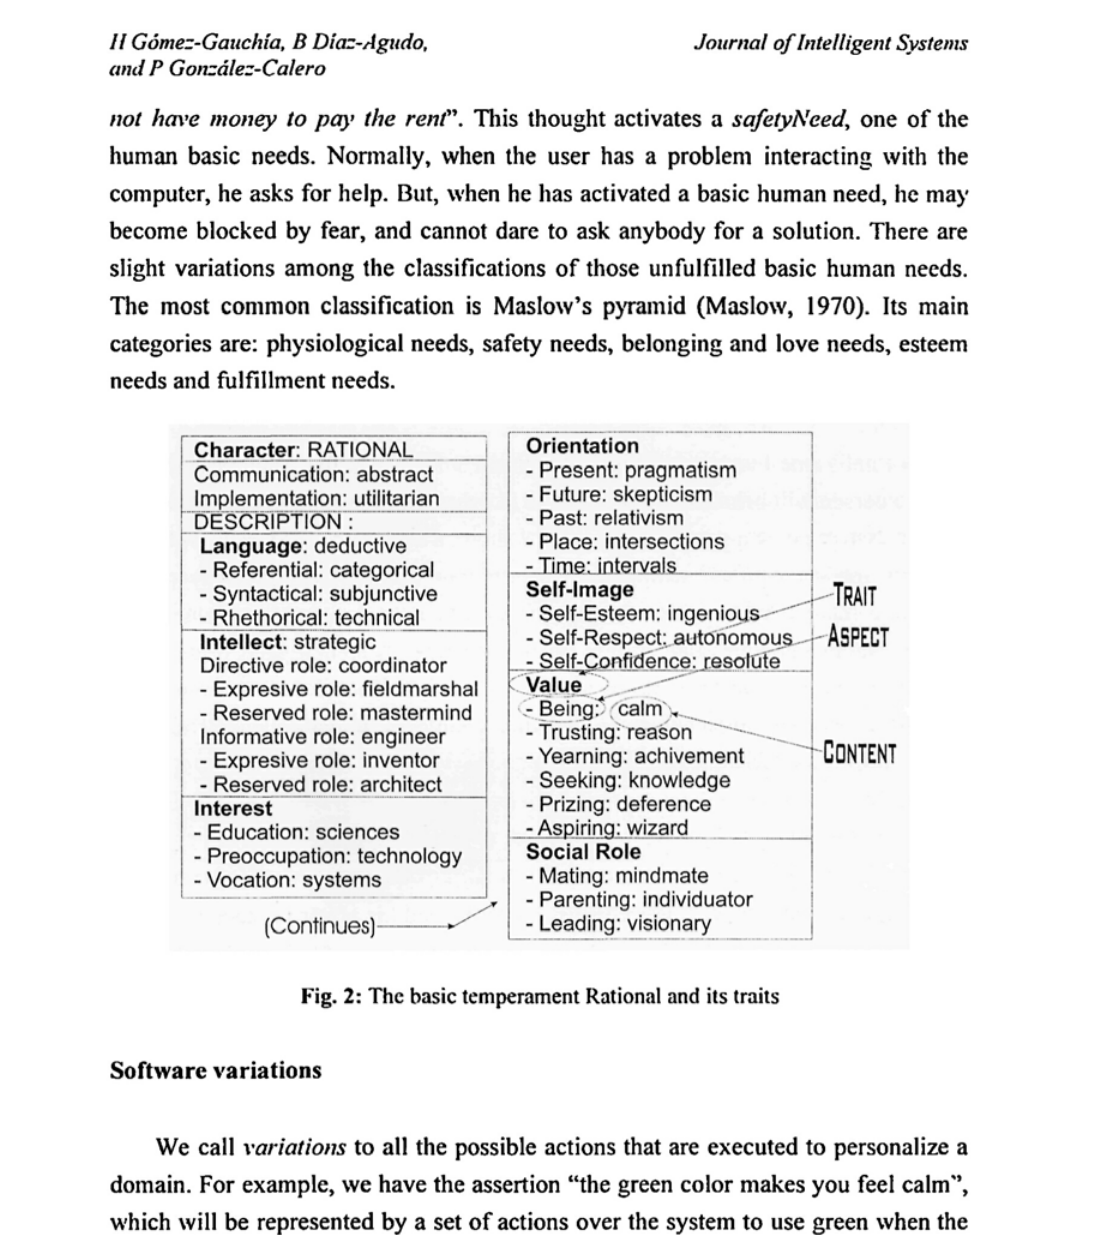
Fig. 2: The basic temperament Rational and its